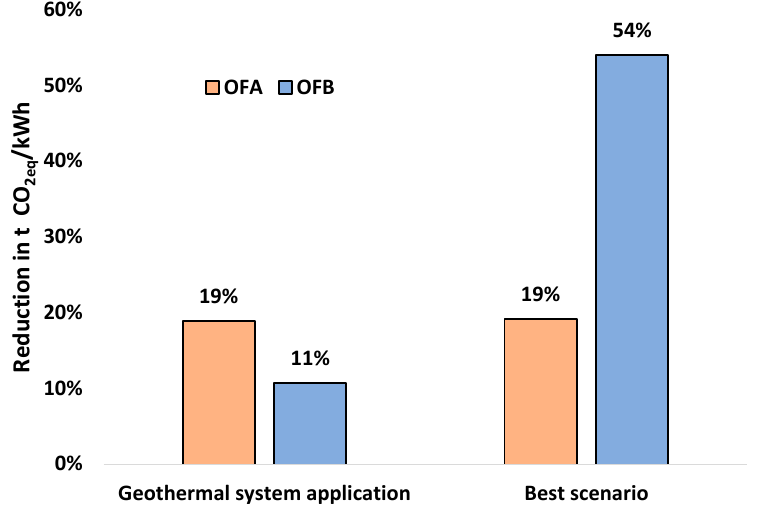
Figure 10. Reduction in tCO 2eq /kWh for the scenarios considered for OFA and OFB.